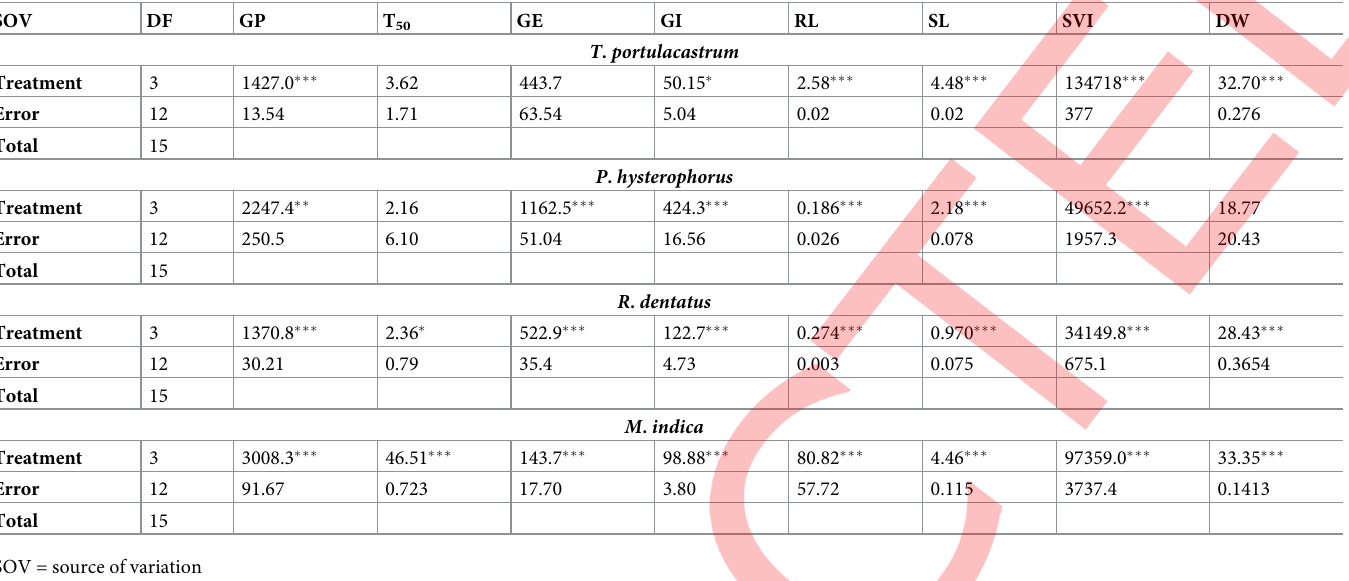
Table 3. Analysis of variance (mean squares) of phytotoxic effect of aqueous plant extracts of Fabaceae plants on germination and seedling growth of different broadleaved weed species. SOV